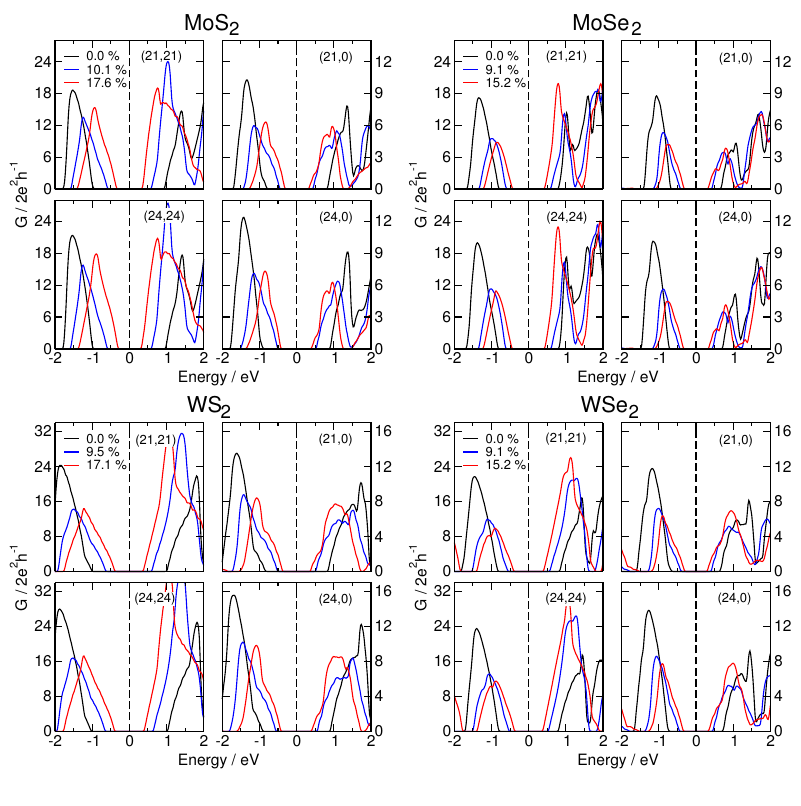
NTs under applied tensile strain along 2